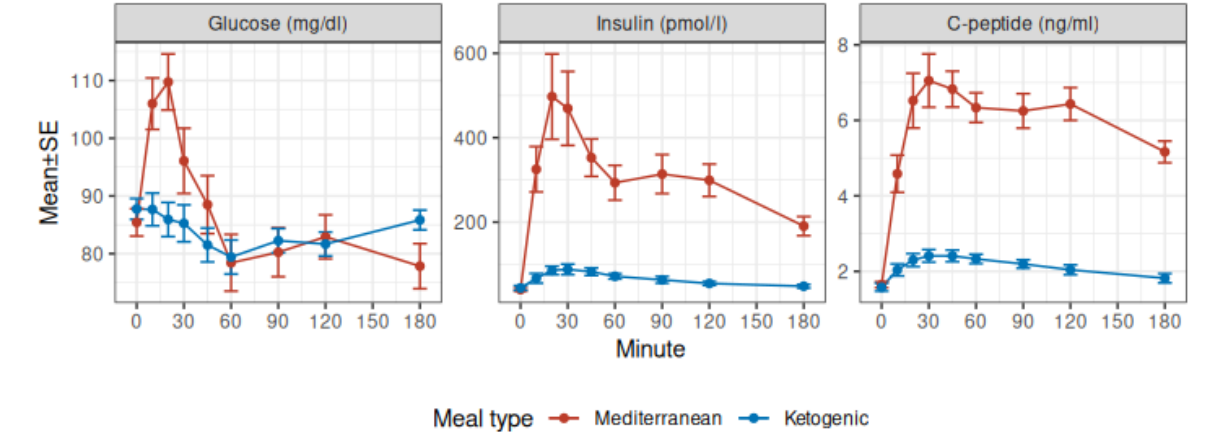
Figure 1. Glucose, insulin, and C -peptide profiles by meal type. Fasting state . Fasting plasma glucose, insulin, and C -peptide were not clinically dif- ferent between the test meal studies (Fisher LSD p -values 0.64, 0.94, and 0.90, respectively). Glucose. After the Mediterranean meal, glucose concentration increased and reached an incremental peak of 24 ± 3 mg/dL at 20 min, then decreased and returned to baseline at 60 min (Fisher LSD p = 0.17). After both meals, glucose concentration decreased signifi- cantly at 60 min (Fisher LSD p = 0.04) with a decremental nadir of −8 m g/dL, 95% CI − 15, − 1 and then returned to baseline at 90 min (Fisher LSD p = 0.14). Compared to the Medi- between 10 and 30 min (Fisher LSD p -values: 10 min p < 0.001, 20 min p < 0.001, 30 min p = 0.04). The mean glucose concentration during the whole